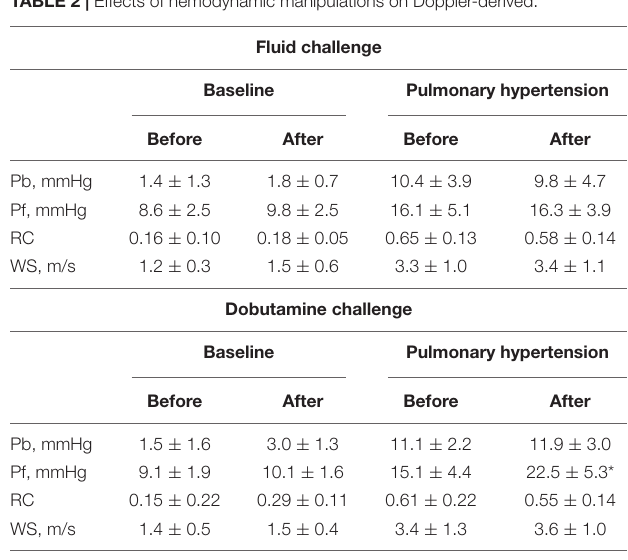
p = 0.78; WS in Dobutamine challenge Baseline before vs. after, p = 0.07; WS in Dobutamine challenge Pulmonary hypertension before vs. after, p = 0.07.